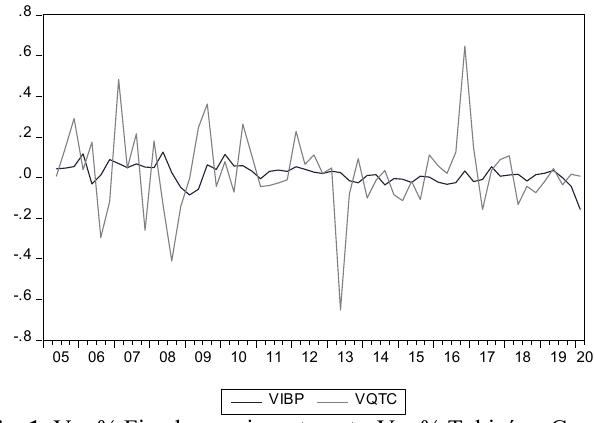
Illustration 1. Var % terms of exchange - Var % private gross